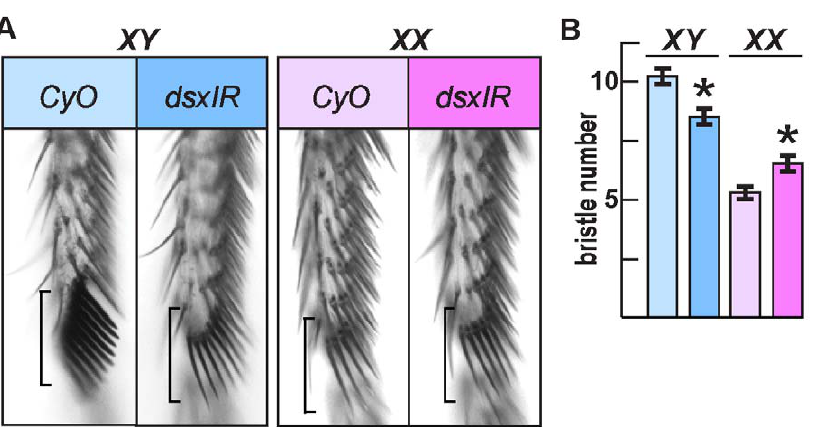
Figure 3. dsx GAL4 -induced expression of UAS-dsxIR at 29 u C causes transformation of a sexually dimorphic row of leg bristles toward an intersexual morphology. (A) Tarsal segment 1 from chromosomal males ( XY ) and females ( XX ) with the dsx GAL4 chromosome alone ( CyO , balancer chromosome) or driving UAS-dsxIR . The regions of the male sex comb and homologous female last transverse bristle row are bracketed. UAS-dsxIR causes the thickness, pigmentation, and taper of bristles to look the same in males and females. (B) Quantitation of bristle numbers from experiment in (A). Histogram bars for the UAS-dsxIR condition are marked with an asterisk for each chromosomal sex. XY CyO males ( n =17 legs) have an average of 10.2 6 0.62 (standard deviation) bristles, which is reduced to 8.5 6 0.61 in XY UAS-dsxIR ( n =19). XX CyO females ( n =19) have an average of 5.35 6 0.49 bristles, which is increased to 6.47 6 0.611 in XX UAS-dsxIR ( n =18).